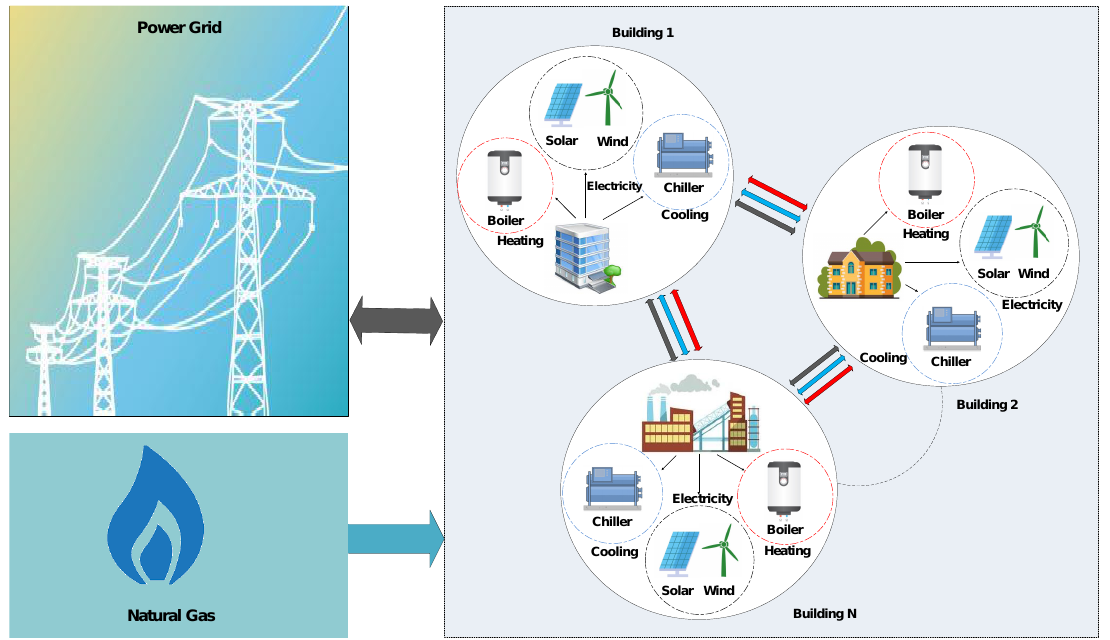
Figure 1. A zone of neighboring buildings driven by RES and utility, sharing their electricity, heating and cooling with other